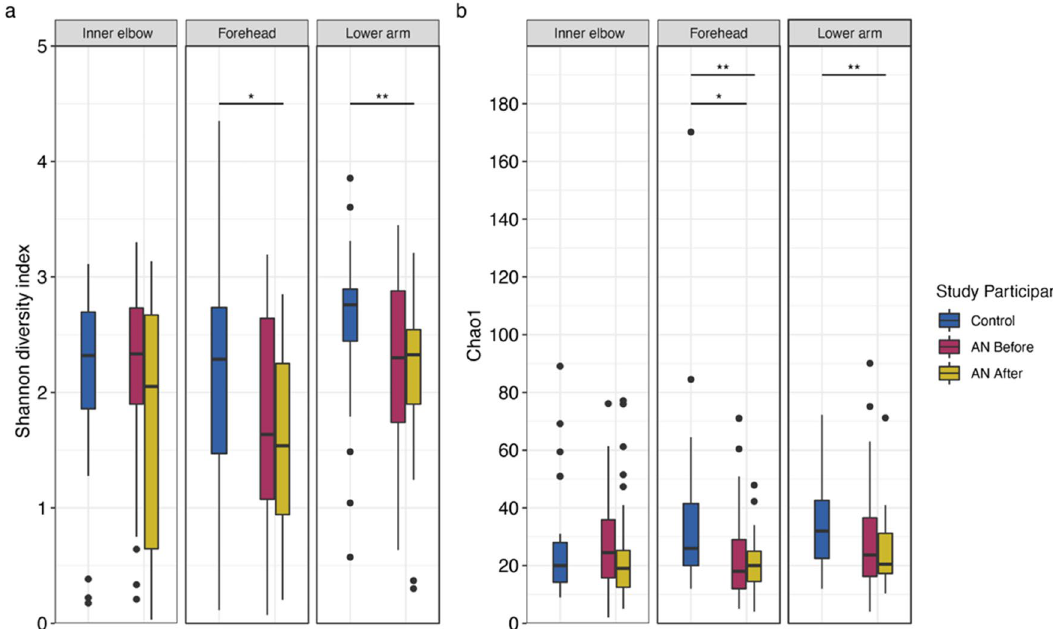
Figure 4. Alpha diversity indices for healthy-weight controls and patients with anorexia nervosa (AN), by weight gain status (before and after), at each sampling location. ( a ) Shannon diversity index. ( b ) Chao1 diversity index. Wilcoxon test (see “Methods” section); p -values: *< 0.05; **< 0.01; ***< 0.001. p -values were adjusted for multiple testing according to Benjamini and Hochberg 94 . Line indicates the median concentration; box shows the interquartile range (IQR), and the whiskers are 1.5 × IQR. Blue represents healthy-weight controls, red represents patients with AN before weight gain, and gold represents patients with AN after weight